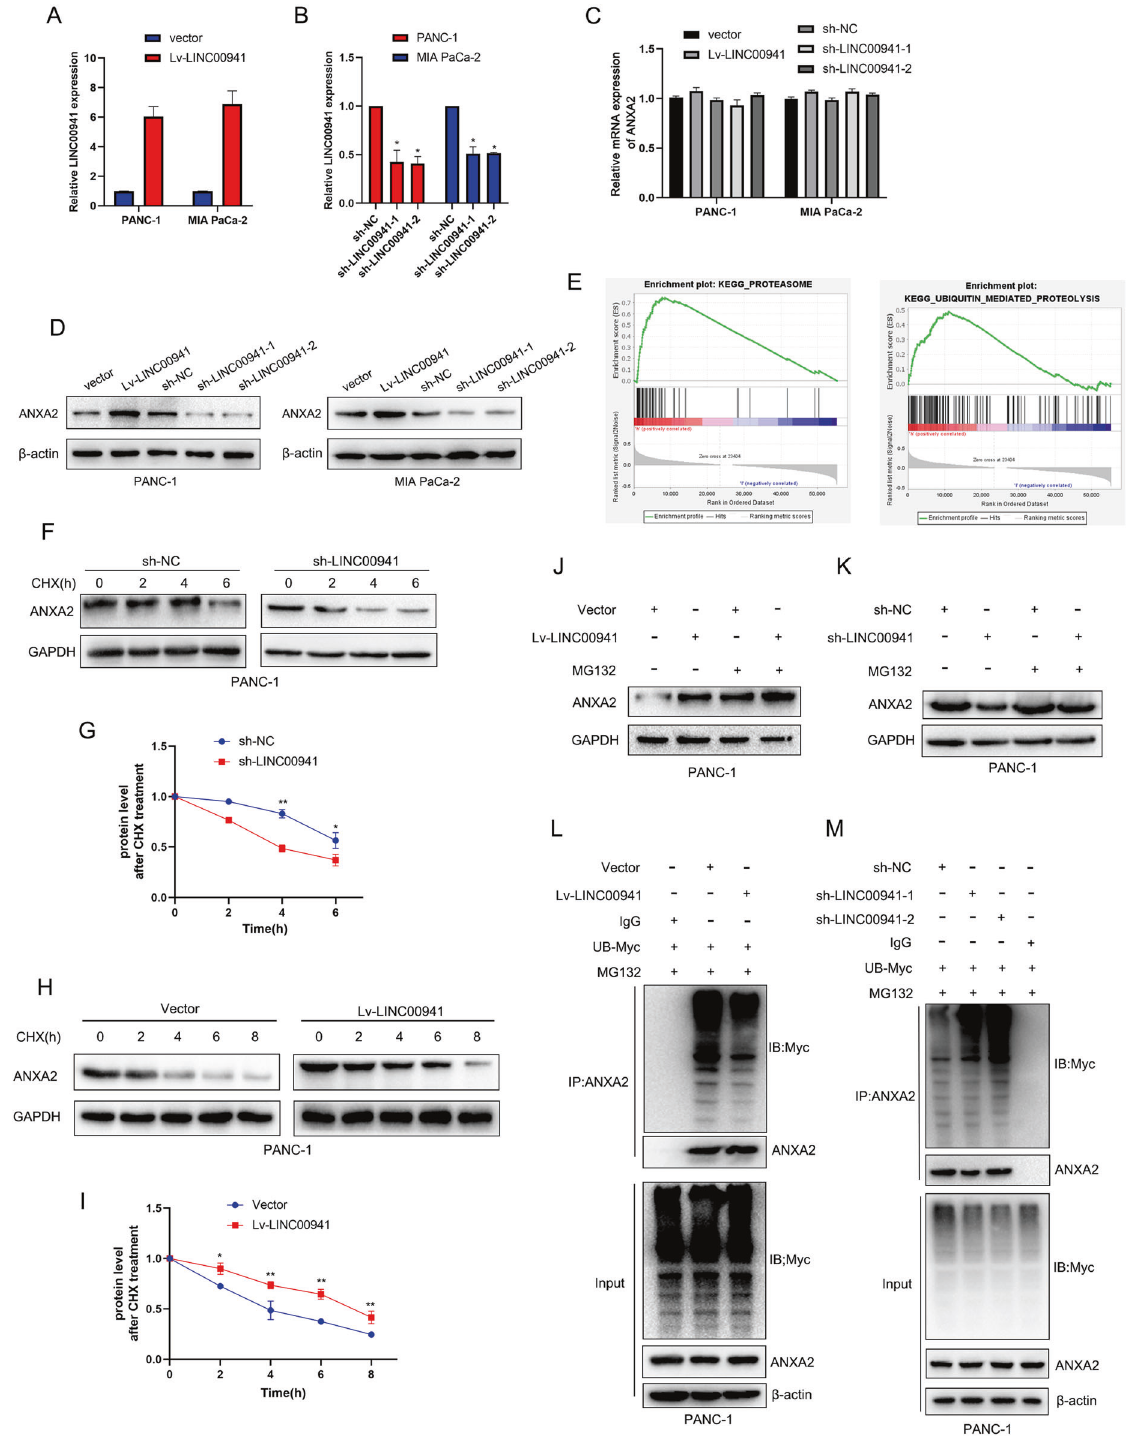
Fig. 3 LINC00941 upregulates the protein expression of ANXA2 by suppressing its ubiquitination. A , B The transfection ef fi ciency of LINC00941 overexpression and knockdown was validated by qRT-PCR analysis. C The mRNA expression level of ANXA2 was measured by qRT- PCR analysis. D The protein expression level of ANXA2 was measured by western blot analysis. E GSEA analysis based on the TCGA database was performed to predict that LINC00941 was positively associated with proteasome and ubiquitin-mediated proteolysis. F – I Protein stability assay by using cycloheximide (CHX, 50 μ g/mL) to treat cells at the different time was performed to evaluate the effect of LINC00941 overexpression ( F , G ) or knockdown ( H , I ), followed by western blot analysis. J , K Western blot analysis of PANC-1 cells stably transfected with LINC00941 overexpression or knockdown and treated with the proteasome inhibitor MG132 (10 μ M). L The ubiquitination of ANXA2 upon LINC00941 or not were analyzed by Co-IP with the treatment of MG132 and Myc-Ubi. M The ubiquitination of ANXA2 in LINC00941 knockdown or negative control group was analyzed by Co-IP with the treatment of MG132 and Myc-Ubi. * and **, respectively, represent P < 0.05 and P < 0.01.